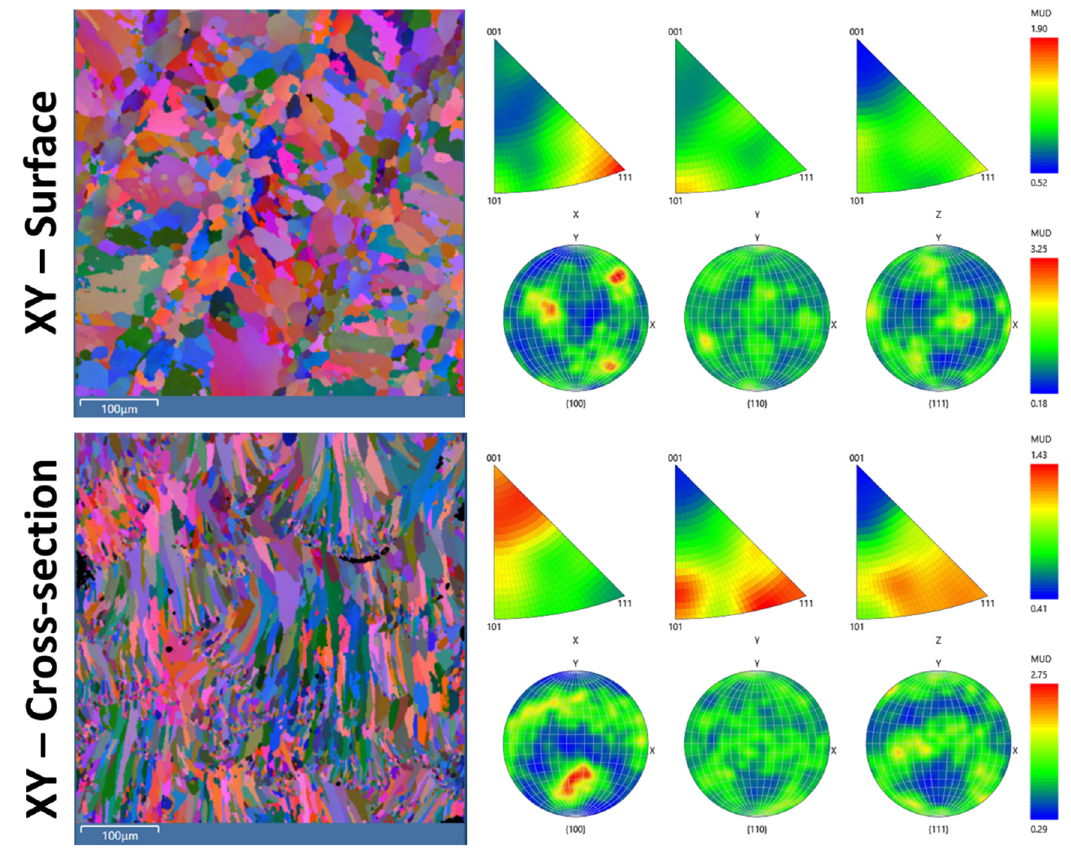
Figure A1. Euler, inverse pole, and pole figures of the side, surface, and cross section for different specimen orientations.